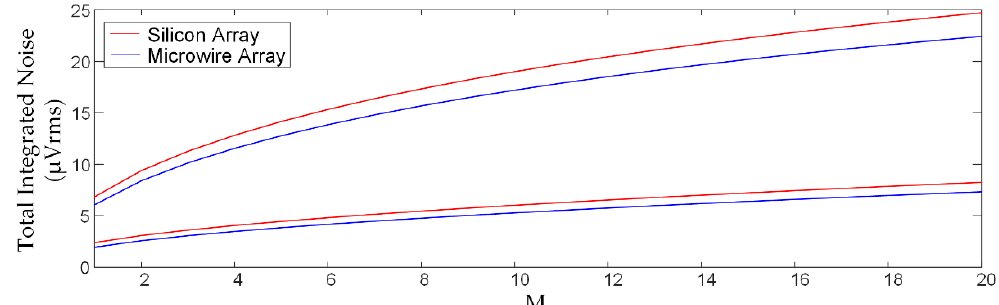
Figure 5. Comparison of voltage sampling (VS, top pair) and windowed integration sampling (WIS, bottom pair) for the representative silicon and microwire arrays using the Figure 4 model with a per channel sampling rate set to f ch = 30 kHz. Voltage sampling results in prohibitively large noise even for M = 4, whereas WIS allows for M = 20 with acceptable noise performance. A design should ideally account for the thermal noise along with expected biological noise and signal amplitudes in order to optimize for in vivo signal detection.